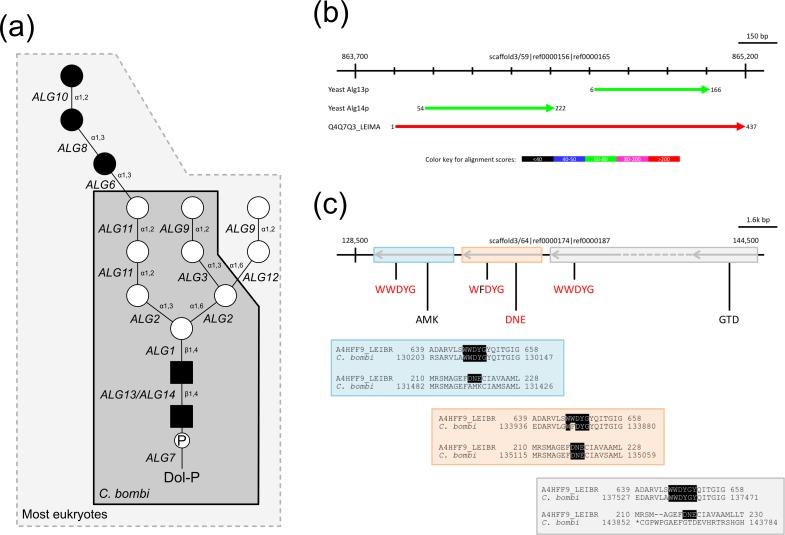
Putative N-glycan synthesis in C. bombi.(a) The complete N-glycan precursor synthesized in most eukaryotes (surrounded by dashed line) is composed of two N-acetylglucosamines (black squares), nine mannoses (white circles), and three glucoses (black circles). However, because C. bombi lacks ALG6, ALG8, ALG10, and ALG12 genes, it was assumed that C. bombi synthesizes biantennary DolPP-GlcNAc2Man7 (grey box, surrounded by solid line). Genes encoding ALG glycosyltransferases responsible for the addition of each carbohydrate are shown in italics together with linkage information. (b) Alignment of yeast Alg13 and Alg14 to a scaffold in the C. bombi genome, showing that these two enzymes are encoded by a fused gene on this scaffold 3/59. (c) Alignments of Leishmania braziliensis STT3 to a scaffold in C. bombi (scaffold 3/64).